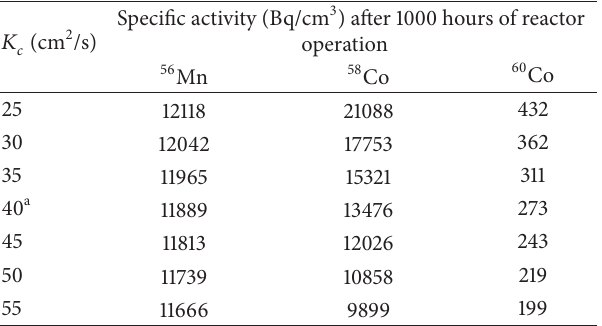
Table 4: Specific activities of 56 Mn, 58 Co, and 60 Co in primary coolant of PWR with different values of 𝐾 𝑐 .